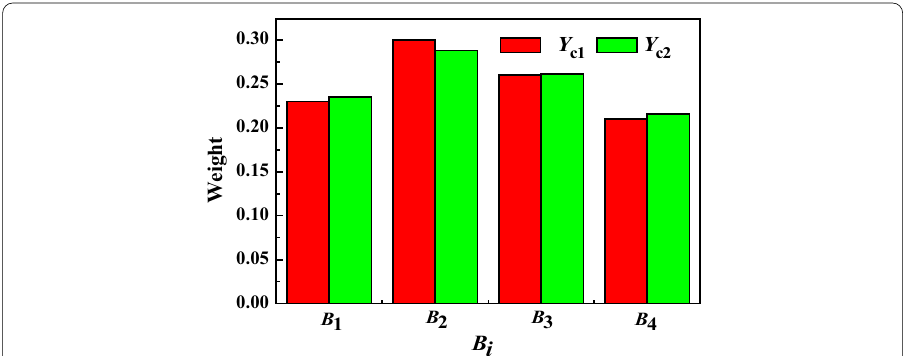
Fig. 7 Weight coefficient of influence degree of the soft measurement values of export products quality